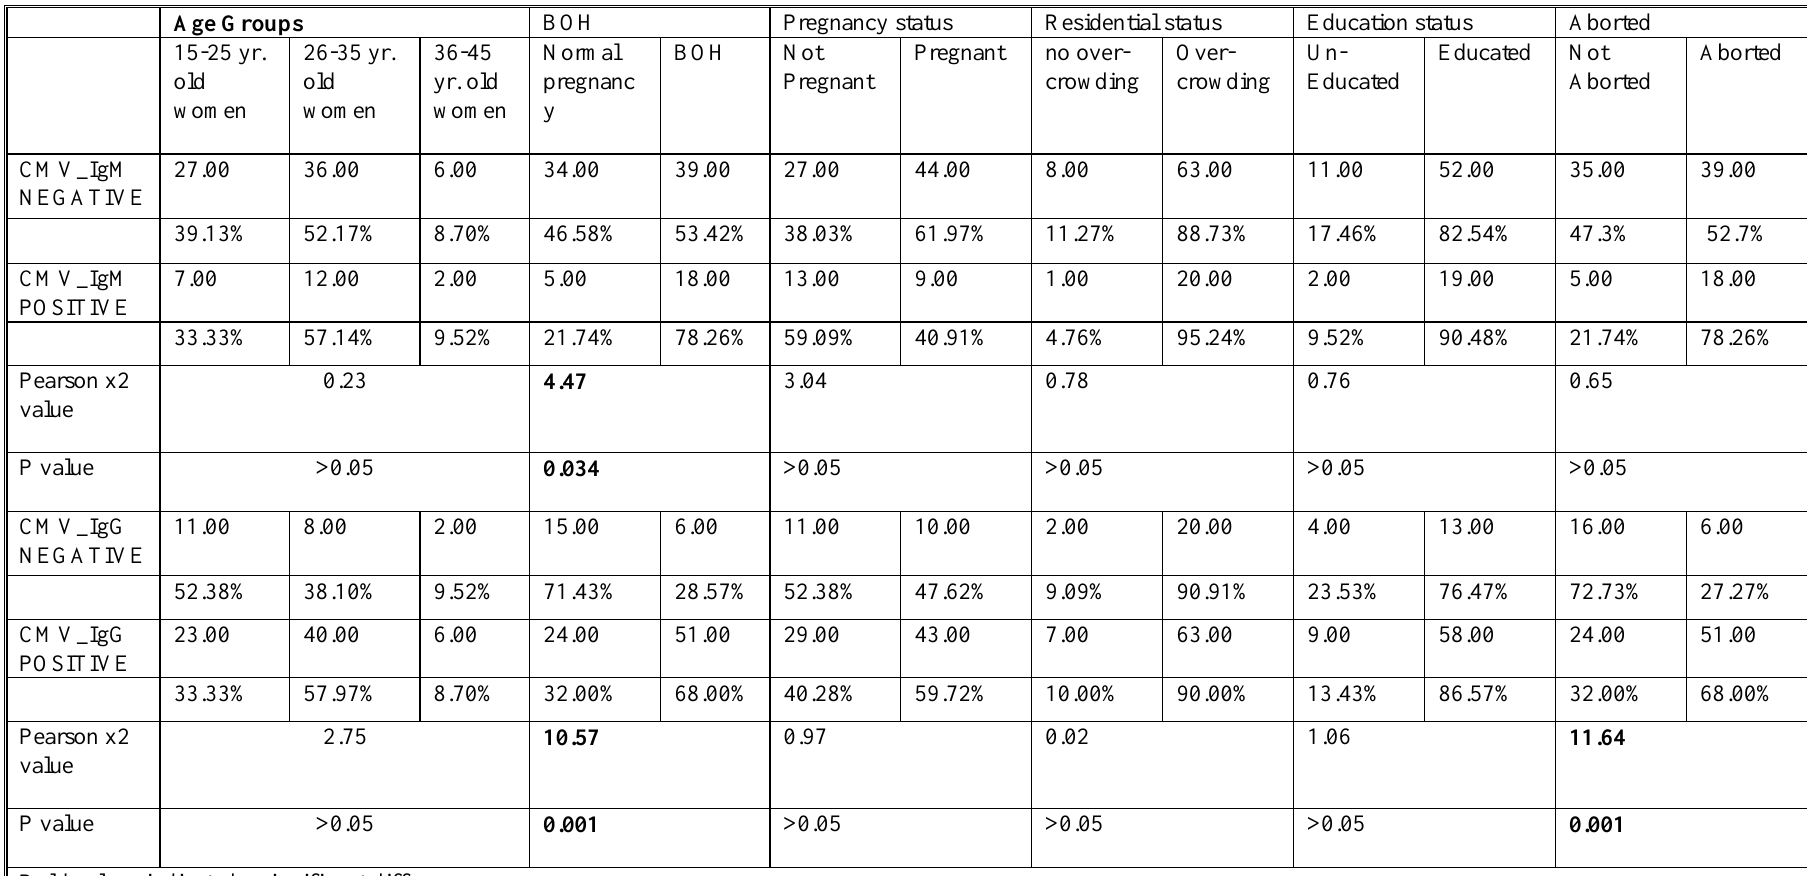
Table 4. Seroprevalence of CMV IgG and IgM in regards to pregnancy, abortion, education, BOH and residential